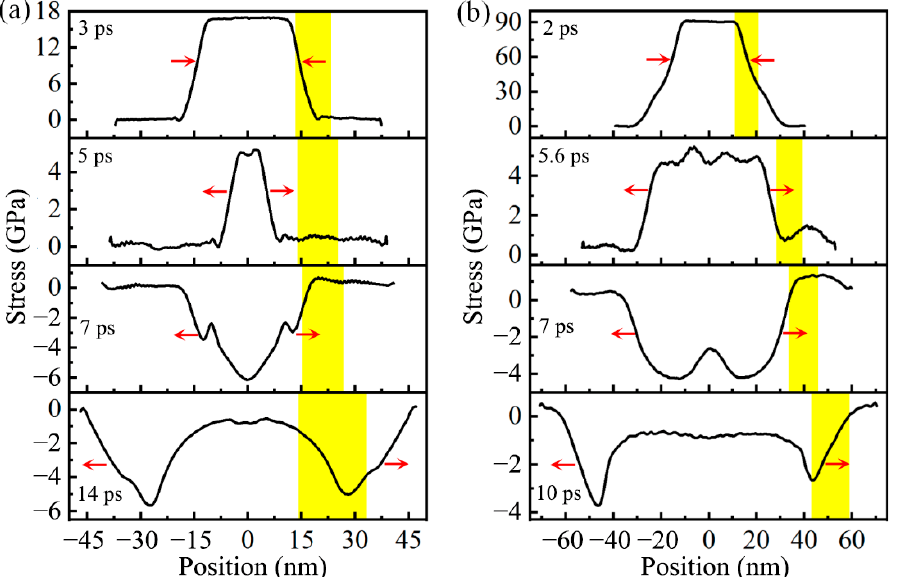
Figure 10. Longitudinal stress profiles under the case of L = 45 a. Two Hugoniot pressure are compared: ( a ) 16.8 GPa and ( b ) 90 GPa. The yellow rectangular region represents the space occupied by the He bubble, where the significant pullback signal of the stress profile is observed.